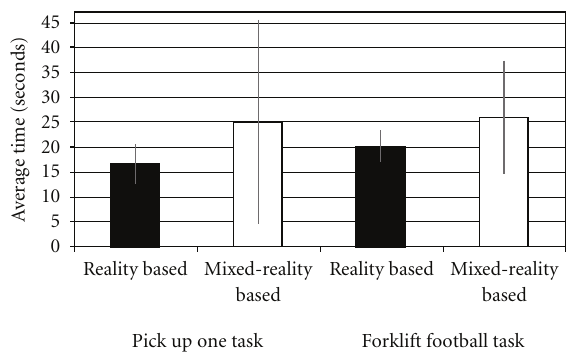
Figure 8: Average times taken (plus standard deviations) for subjects to complete the reality-based and AR-based versions of the pick-up-one and forklift football tasks.